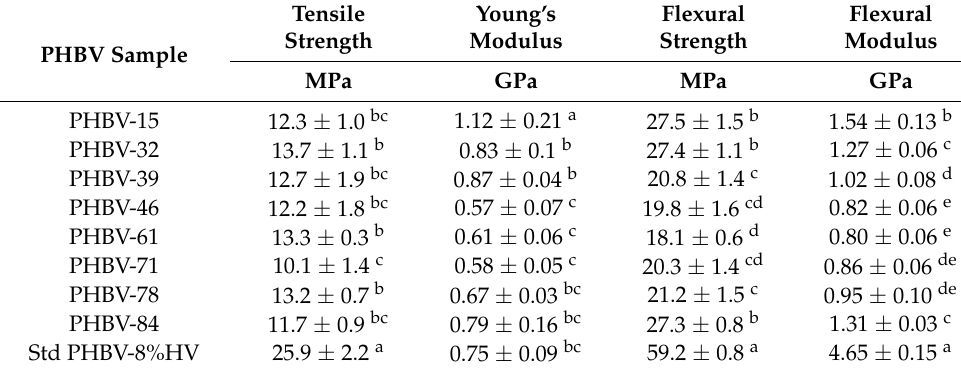
Tensile Young’s Flexural Strength Modulus Strength